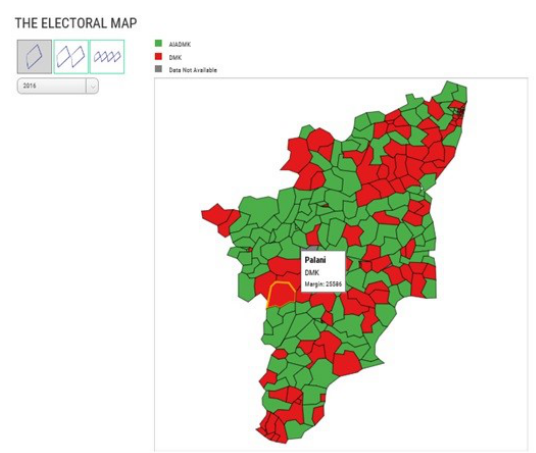
Figure 12: Detailed Electoral Map for Tamil Nadu for a Particular Year Provided Drop-Down Menu for Selection of Year (from 1980-2016).